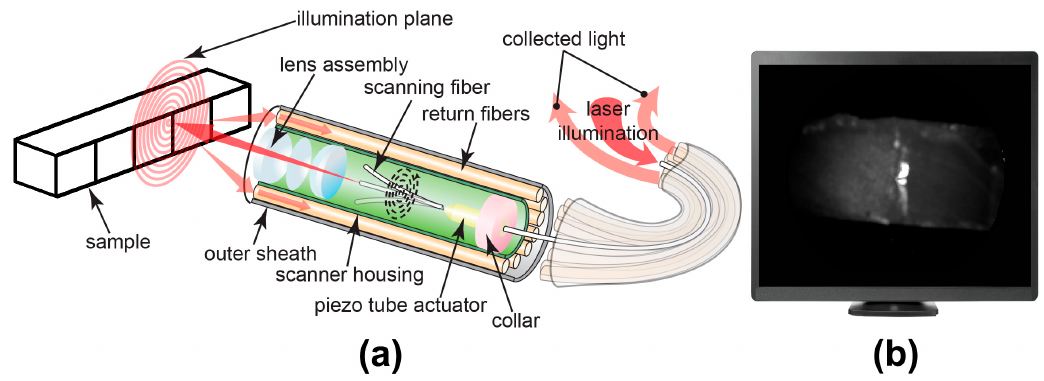
Figure 2. ( a ) The image on the left shows the tip of the NIR SFE imaging the test sample with NIR scanning laser light in a spiral pattern. The rigid length containing the vibrating illumination fiber and lenses is 9-mm long and 1.6-mm in diameter. ( b ) The image on the right shows a NIR SFE digital image displayed on a computer monitor, which matches the field of view shown in ( a ).